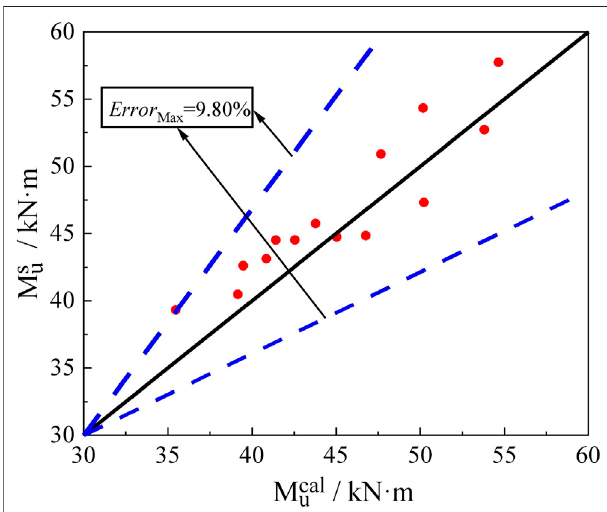
FIGURE 16 | Comparison of M cal u and M s u for 14